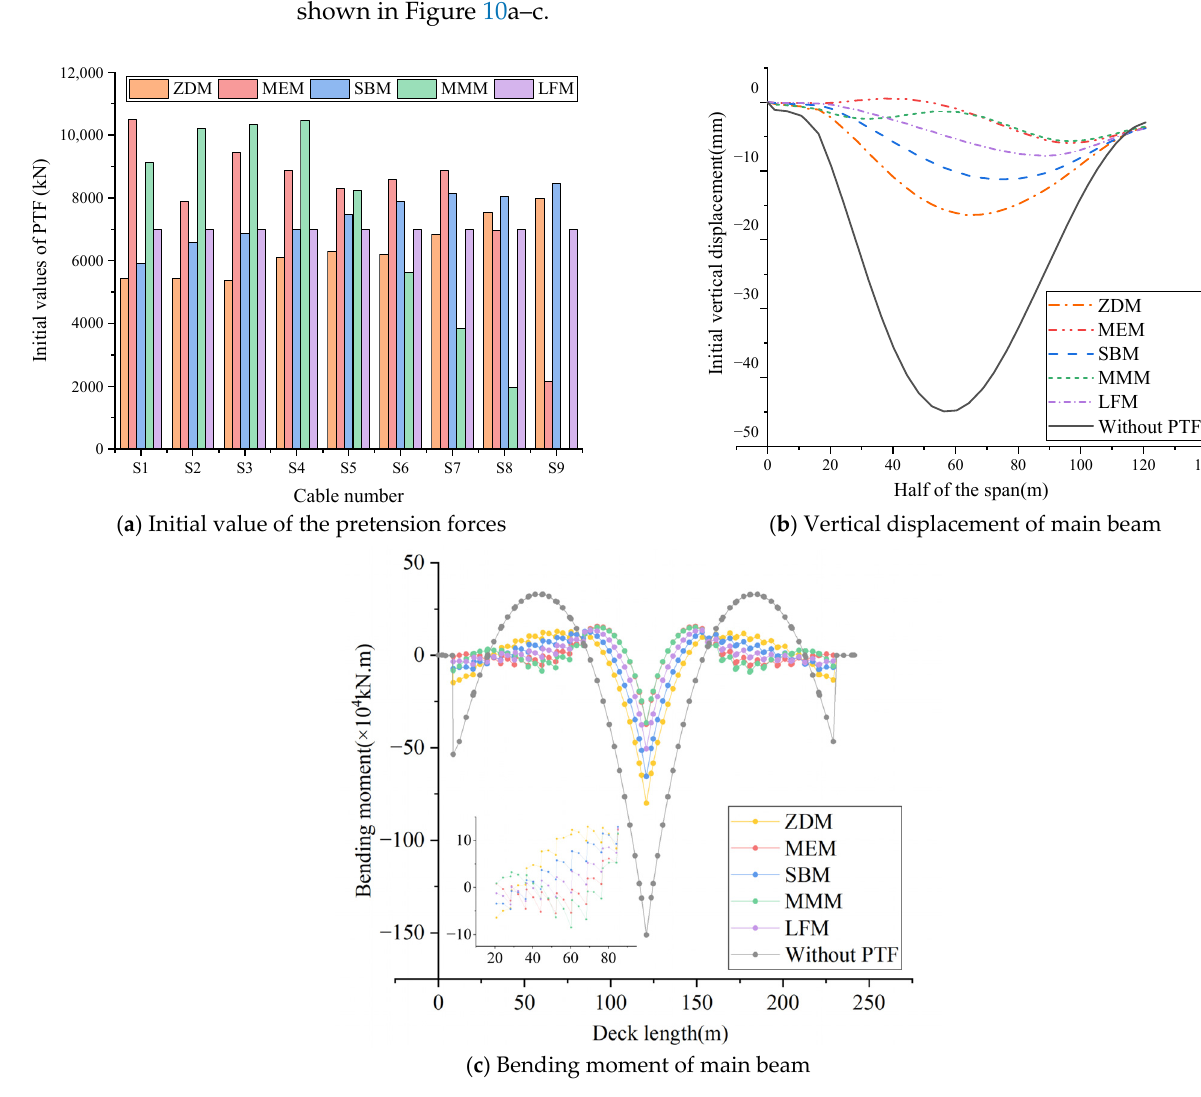
Figure 10. Structural response of cable-stayed bridge in the initial state calculated by different meth- ods.